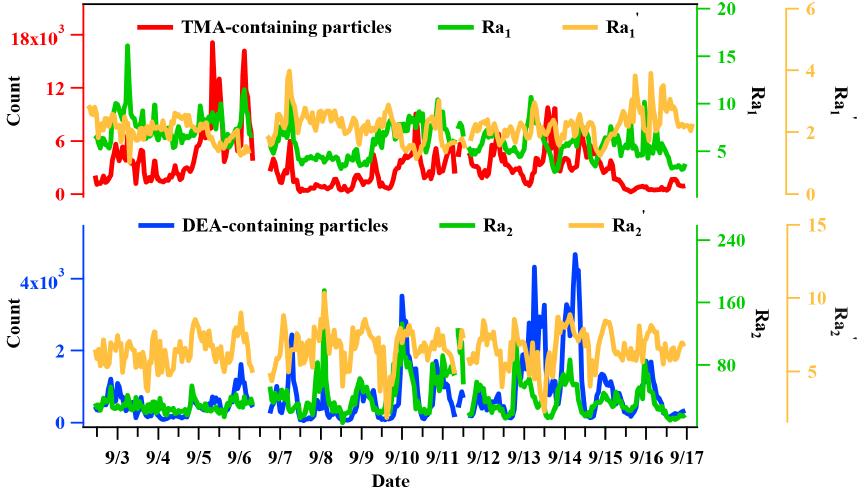
Figure 11. Temporal trends of the relative acidity ratios (Ra; Ra (cid:48) ) in TMA- and DEA-containing